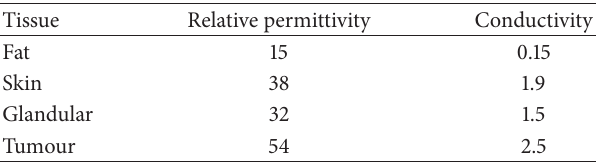
Table 2: Relative permittivity and conductivity of breast tissue at frequency range from 200 MHz to 5 GHz